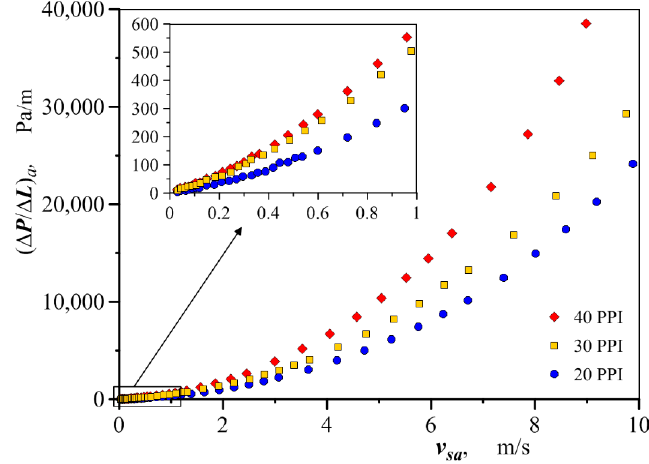
For oil flow, the change in pressure drop is almost linear (Figure 5). Air and water pressure drop also change in a linear manner when their velocities are relatively low ( v sw < 0.03 m/s and v sa < 1 m/s). The linear dependence between pressure drop and fluid velocity is indicative of a laminar flow regime. With increasing velocity, the flow gradually changes to turbulent. For oil, the flow is laminar over the entire range of velocity changes. This is due to the fact that oil is several times more viscous than water.